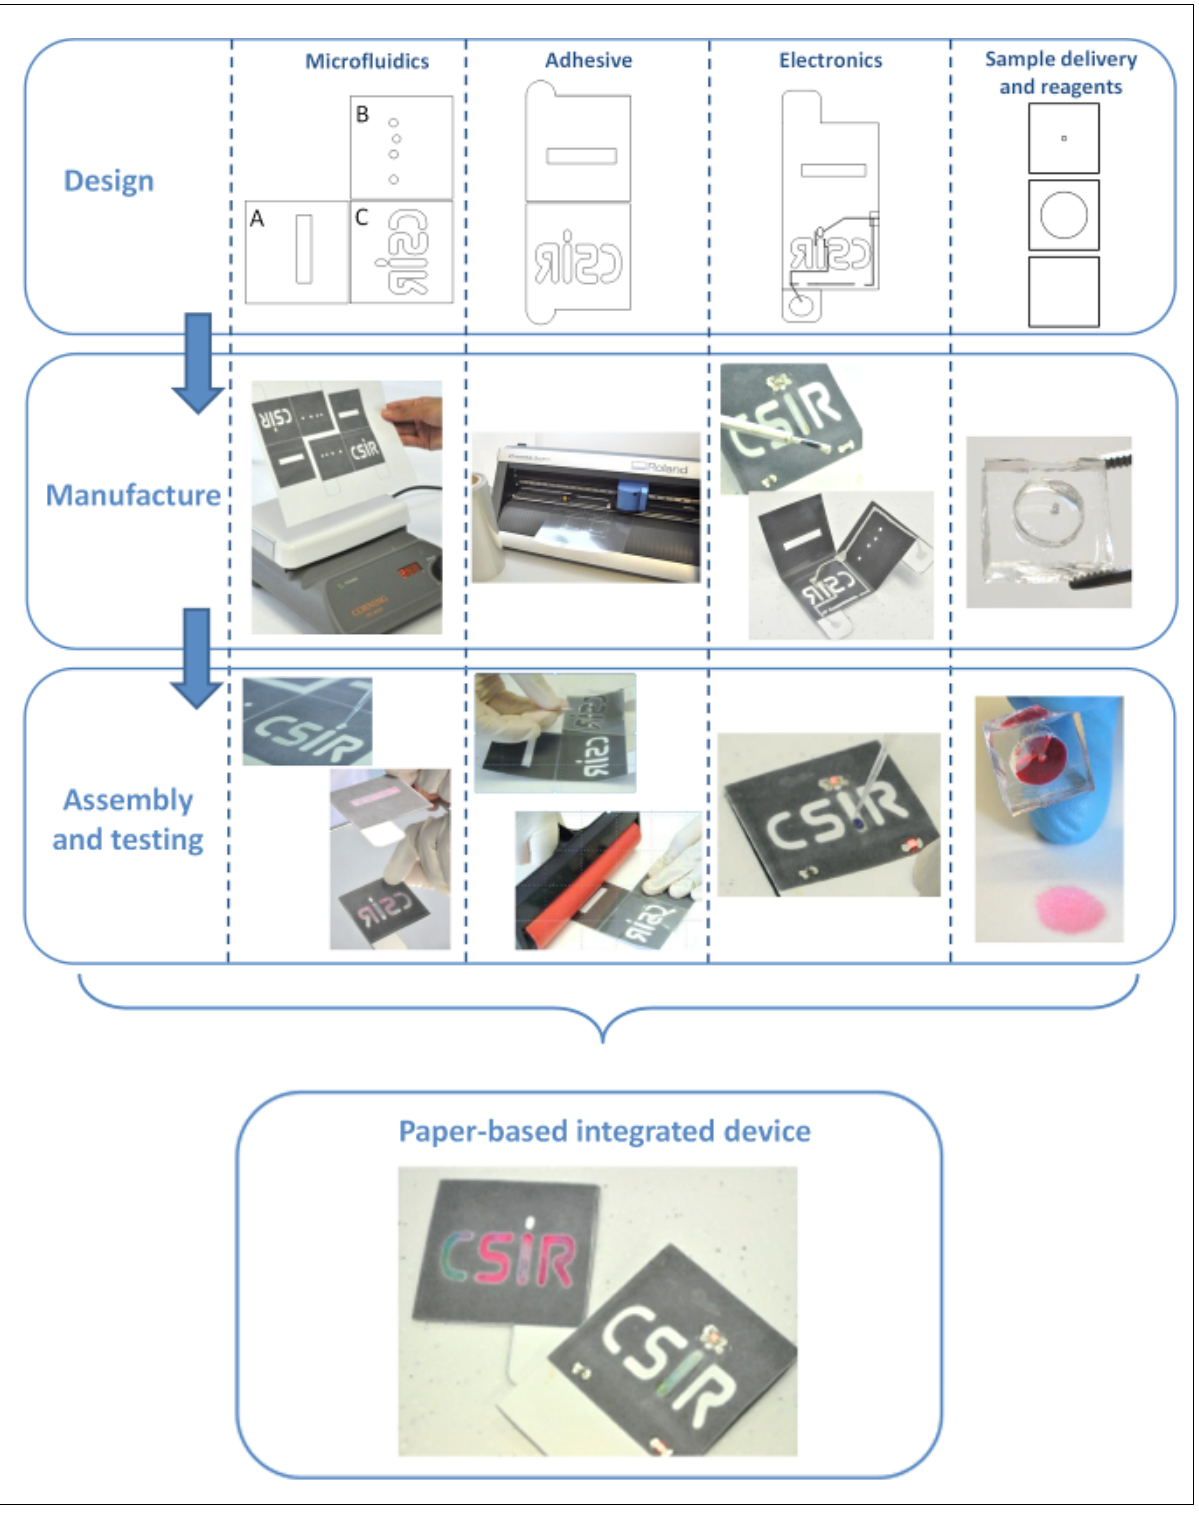
Figure 10: Collage showing the design, manufacturing, assembly and testing steps of the fully operational integrated electronics-enhanced microfluidic origami device. Each step encompasses microfluidic, adhesive, electronic and sample delivery components. The design step consists of the computer aided designs for the microfluidic paper device design (illustrated in Figure 1), the adhesive layer design (shown in Figure 3), as